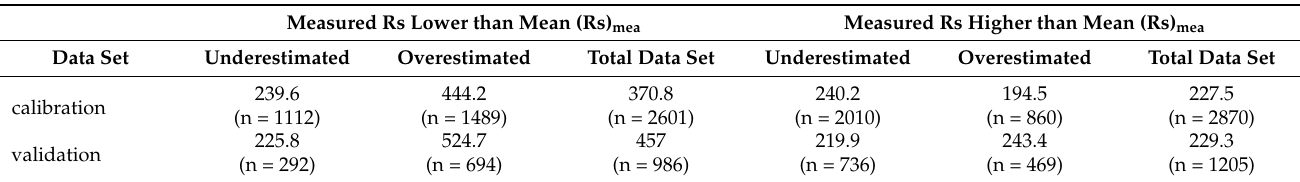
Table 12. RMSE values (J · cm − 2 · day − 1 ) and number of data points belonging to under- and overestimation sets for measured solar radiation less or higher than mean (Rs) mea in calibration and validation phases using proposed